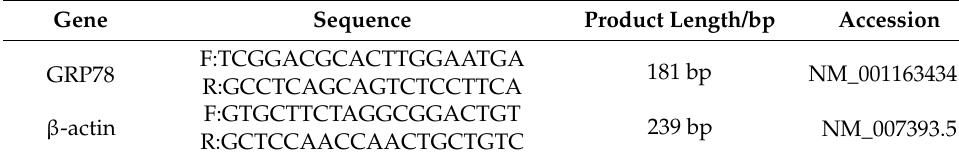
Table 2. Primer sequences of real-time